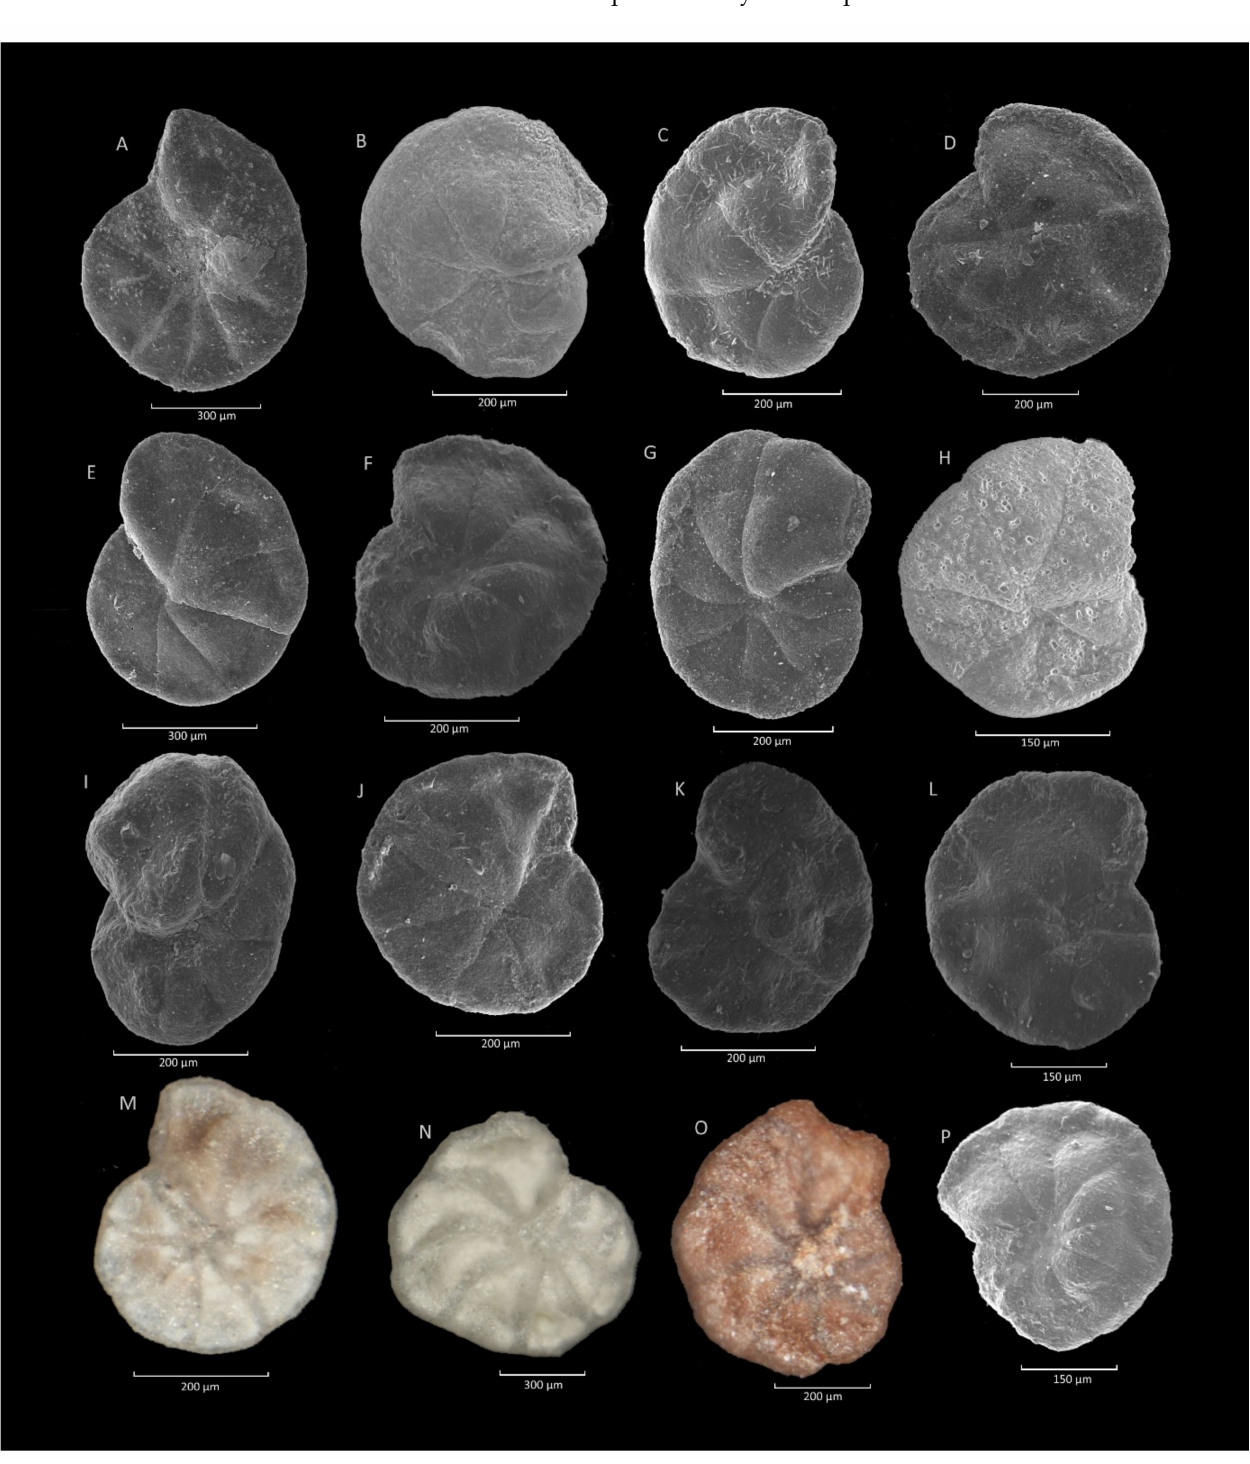
Figure 18. Haplophragmoides walteri (Grzybowski). ( A , C , D , J , L , P ): Krzesławice section; ( B , H ): Jezioro Ro˙znowskie section; ( E , F , L ): Stradomka section; ( G , K ): Leszczawa section; ( I ): Sucha Beskidzka section; ( M , N ): Gorlice section; ( O ): Zamczysko